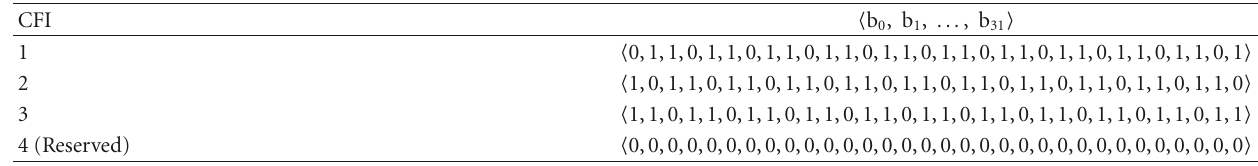
Table 3: CFI (32,2) Block code